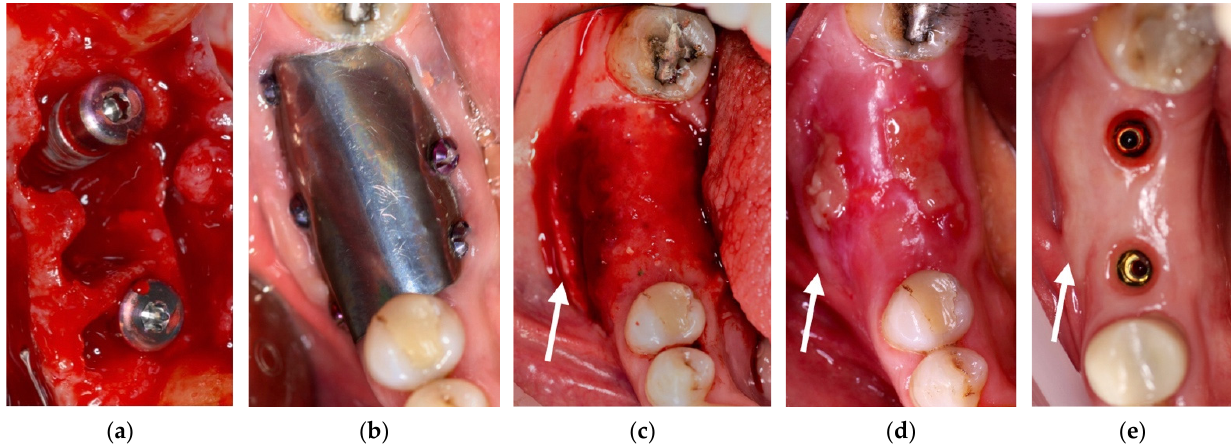
Figure 11. ( a ) Avulsion of the teeth and simultaneous insertion of the implants; ( b ) Use of the enriched clot and cover with the foil blocked with the screws; ( c ) Removal of the foil at six months; ( d ) Maturation of the tissues after one week from the withdrawal of the foil; ( e ) pre-prosthetic situation of implants and mucosa.